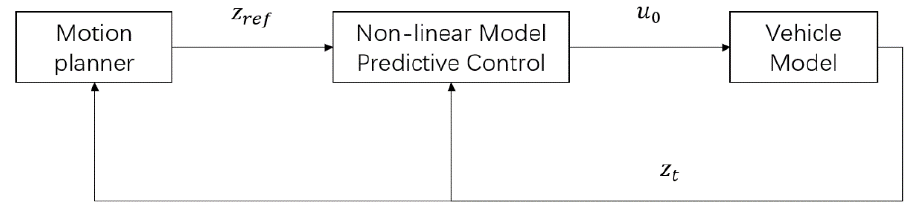
Figure 1. Simplified architecture of vehicle trajectory following.